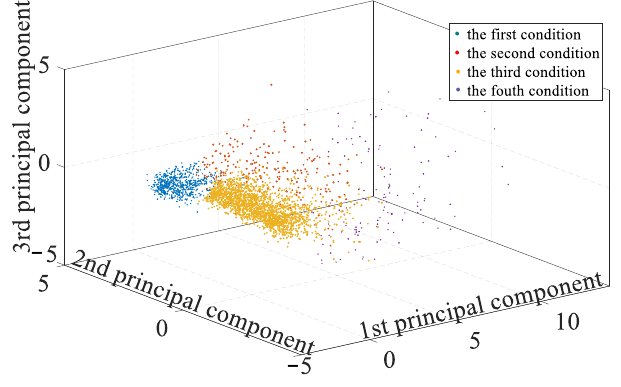
Figure 8. The clustering result of segments. In reference to the statistical analysis of the clustering result, the four clustered sets are defined as four different driving conditions, which is respectively highway, urban road, national highway and others. Average values of these twelve parameters for the four conditions are shown in Table 3. RDE test simply divides three driving conditions from each other with maximum speed. On the contrary, this paper take not only the maximum speed, but also the average speed, ratio of idling and deviation of the acceleration into account. In Highway presents the highest average speed and lowest average acceleration and the deviation of acceleration, indicating that the road condition is clear. Urban road presents a lowest average speed and shows relatively high ratio of idling, deviation of acceleration. Nation highway shares a relatively high average speed but lower than that of the highway, and shows a low deviation of acceleration. Others shows a lowest average speed and highest ratio of idling, which means there whether exists a traffic jam or simply a start-stop scenario. Table 3. Average values of characteristic parameters of four